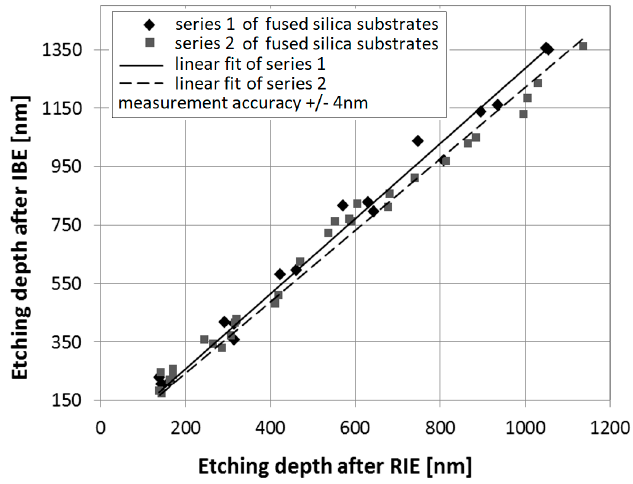
Figure 7. Linear relation between the etching depth after RIE (d RIE ) and after IBE post processing (d IBE ).